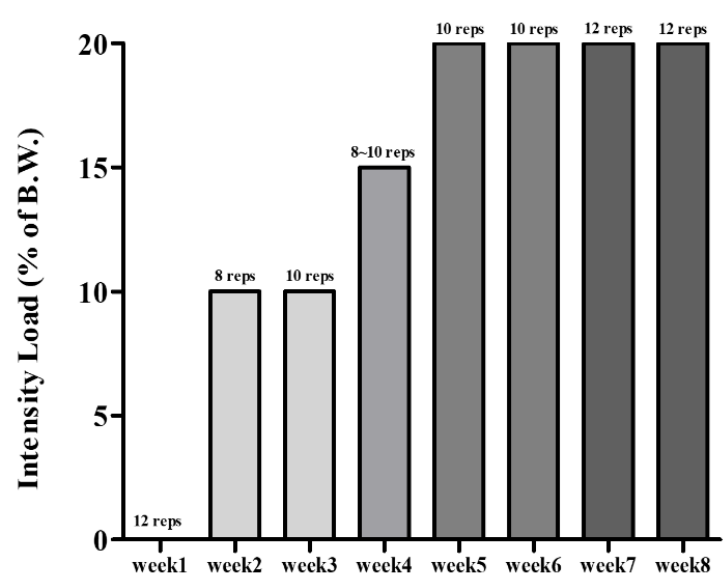
Figure 2. The incremental intensity load applied to the resistant exercise.